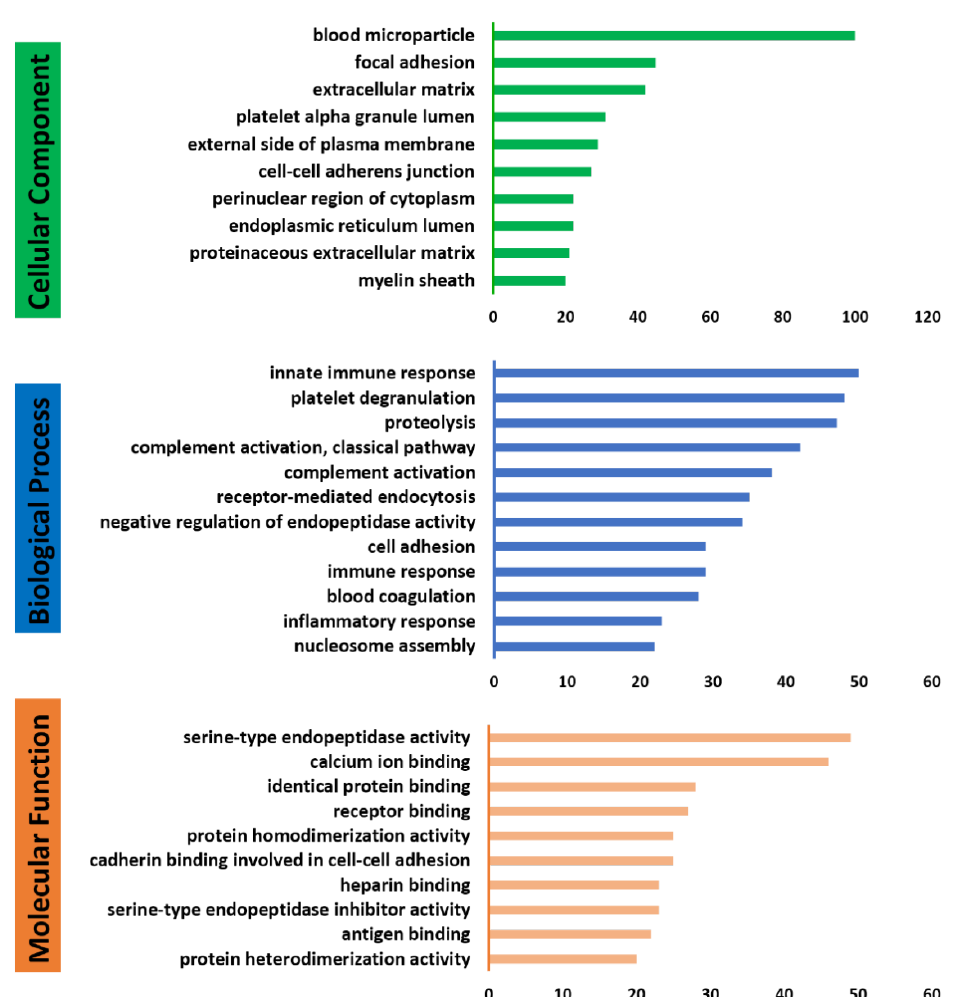
Figure 2. Among the 24 plasma samples, analysis of the biological process, molecular function, and cellular component of plasma differential proteins.